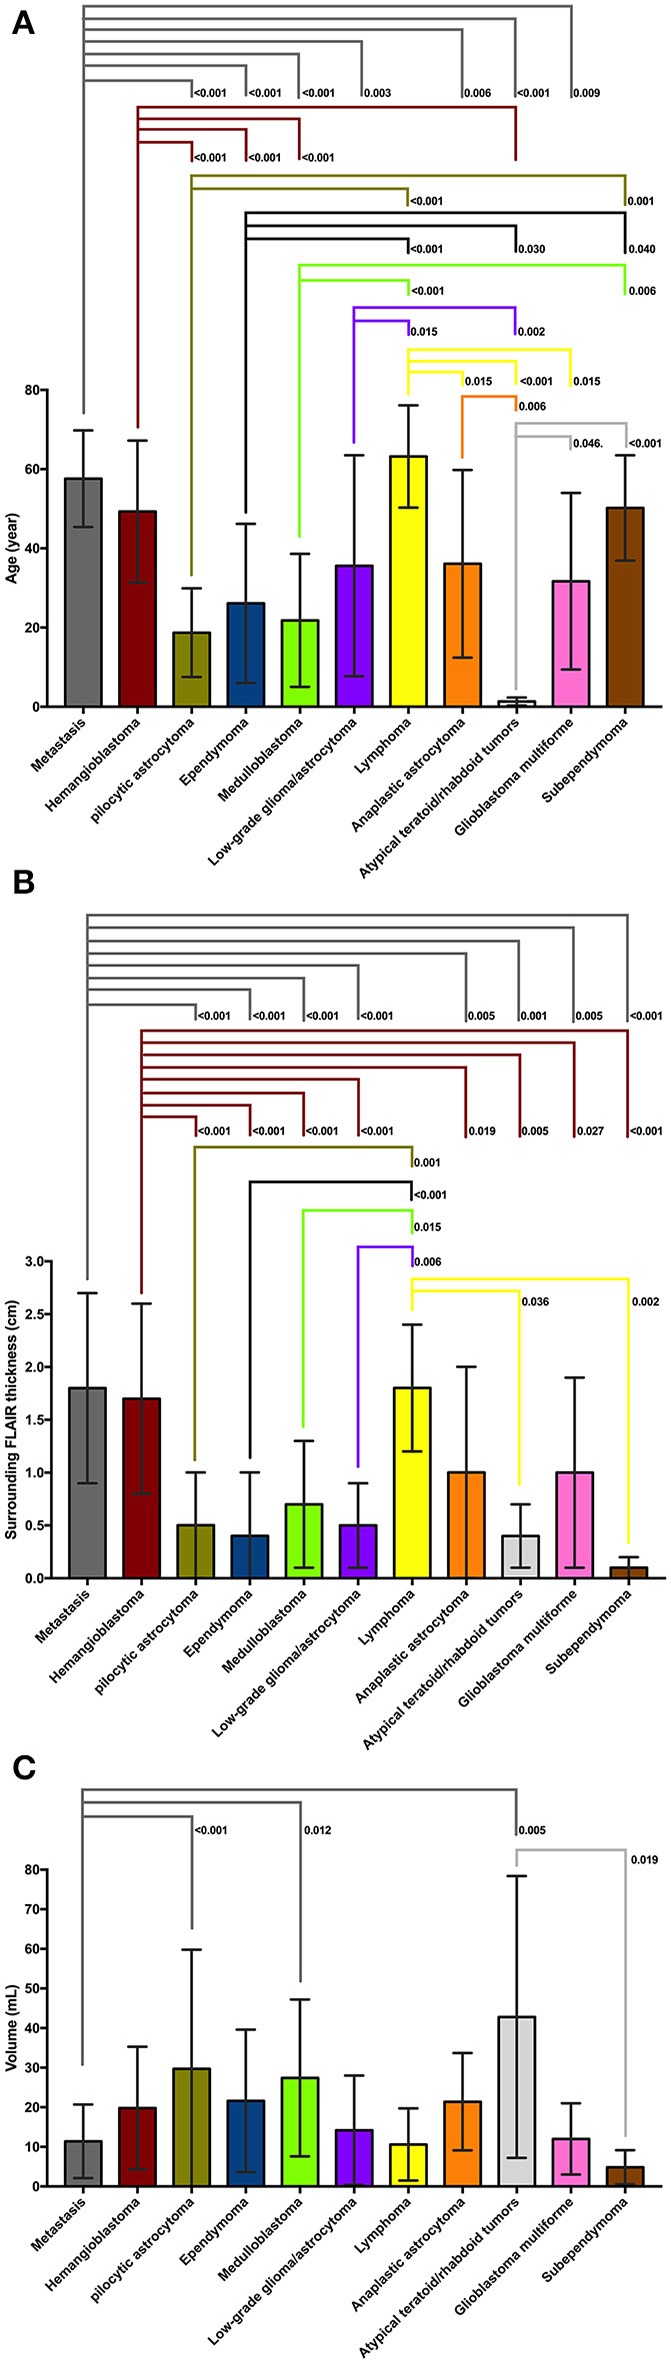
(A) On post-hoc analysis, patients with atypical teratoid/rhabdoid tumors (ATRT) had significantly lower age at presentation compare to all other tumor types except medulloblastoma and pilocytic astrocytoma. Patients with medulloblastoma, pilocytic astrocytoma, and ependymoma were significantly younger compared to those with metastasis, lymphoma, hemangioblastoma, and subependymoma. Patients with metastasis and hemangioblastomas were also older than those with anaplastic astrocytoma, low-grade glioma, and glioblastoma multiforme. (B) On post hoc analysis, metastases, hemangioblastomas, and lymphomas had larger diameter of peritumoral FLAIR hyperintensity compared to medulloblastoma, pilocytic astrocytomas, ependymomas, low-grade glioma, ATRT, and subependymomas—likely since latter tumors tend to be intraventricular with virtually no peritumoral edema. Also, the peritumoral FLAIR hyperintensity surrounding metastases, and hemangioblastomas was larger in diameter compared to anaplastic astrocytoma, and glioblastoma multiforme. (C) On post hoc analysis of tumor volumes, pilocytic astrocytomas, medulloblastomas, and ATRTs had larger size compared to metastases. The ATRTs were also significantly larger compared to subependymomas. ATRT, atypical teratoid/rhabdoid tumors; FLAIR, fluid attenuated inversion recovery.